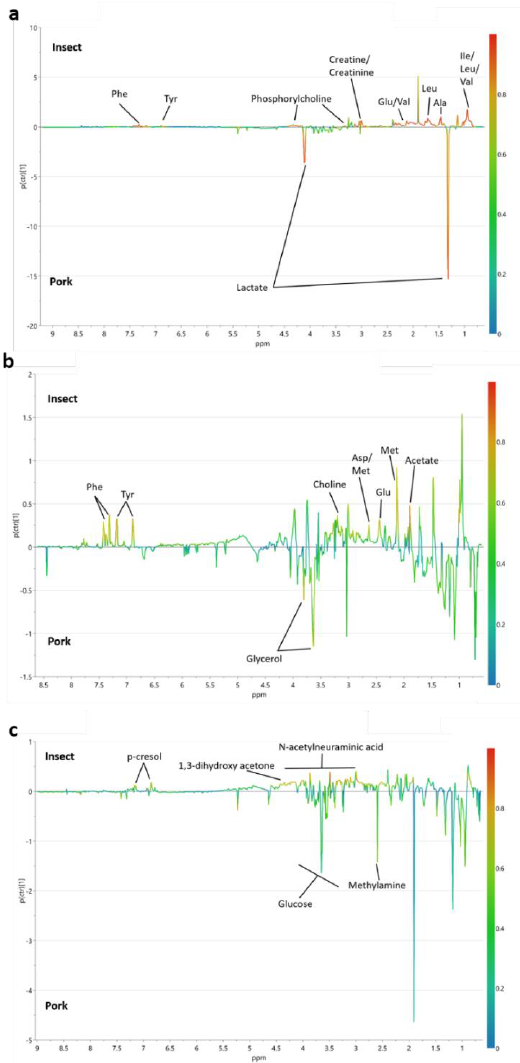
Figure 4. S-line plots from orthogonal partial least squares discriminant analysis of 1 H NMR spectro- scopic data on insect-substituted pork sausage diet (Insect) versus pork sausage diet (Pork) analysis. Stomach content, Q 2 = 0.96 ( a ), small intestinal content, Q 2 = 0.67 ( b ) and colon content, Q 2 = 0.59 ( c